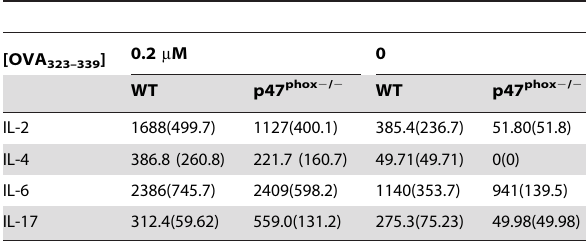
Mean (SEM) in pg/mL, n=4. IFN c /LPS matured DC were pulsed for 2 hours with OVA 323–339 peptide at the indicated concentrations, and cocultured with naı¨ve OT-II CD4 + lymphocytes. Supernatants were collected at 96 hours, and analyzed by a bead-based multiplex ELISA.